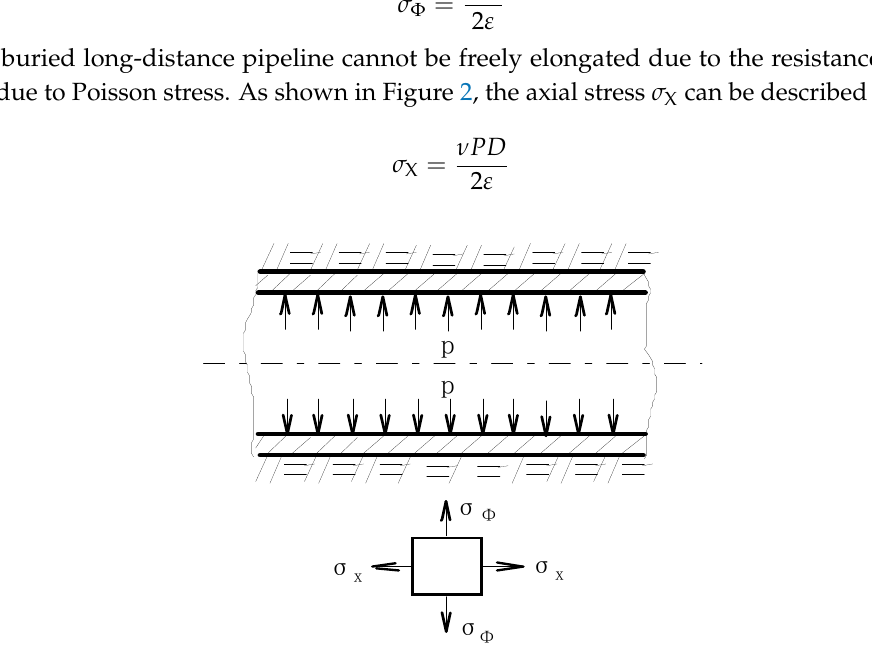
Figure 2. Pressure pipeline model.